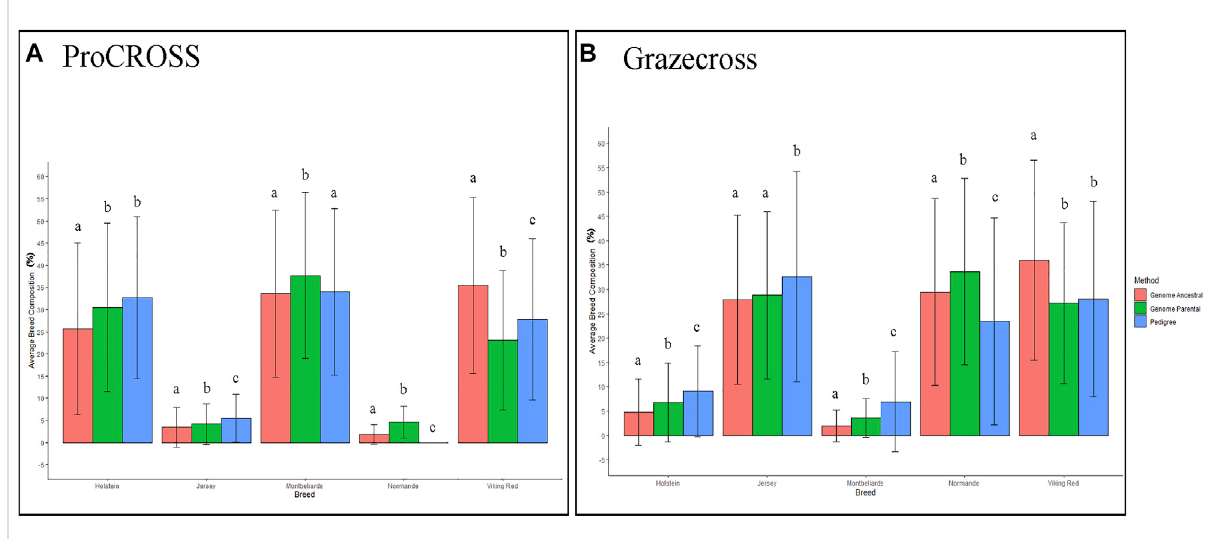
FIGURE 5 Comparison of average breed composition based on pedigree and genomic breed estimations comparing VKR population in fl uence. Barplot A isfor ProCROSS datasetsandBarplotBisforGrazecrossdataset. X -axisrepresenttheaveragebreedcomposition; Y -axisprovidesthepercentageof breed composition. A t -test is used to compare between the methods/datasets the change in breed composition average. Error bars use one standard deviation and letters indicate signi fi cant difference between estimations with p -value < 0.05 within breed